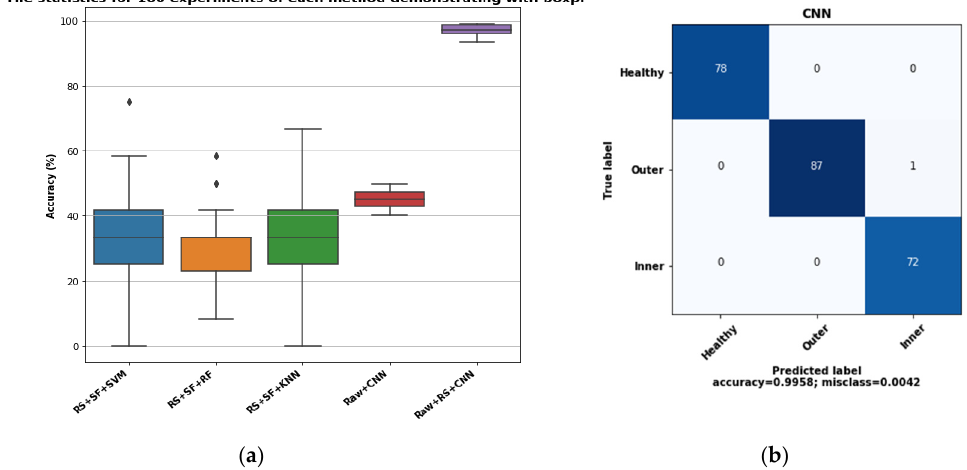
Figure 9. ( a ) The boxplot representing the accuracy matrix of over 100 experiments; ( b ) confusion